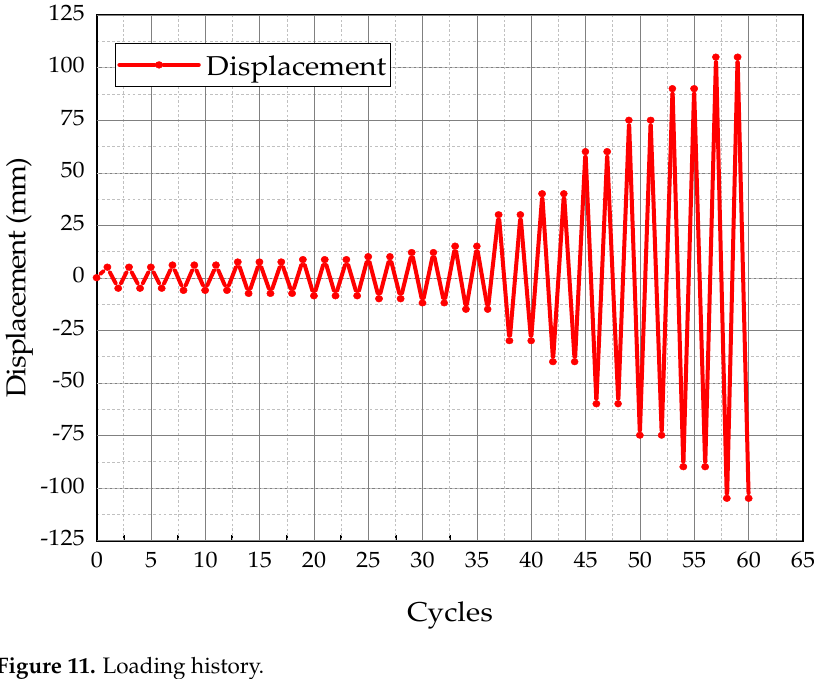
Figure 11. Loading